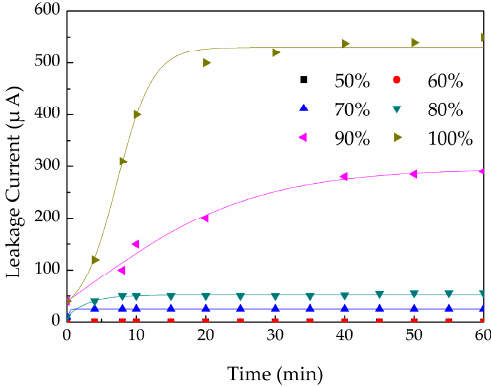
Figure 10. The leakage current with different relative humidity.